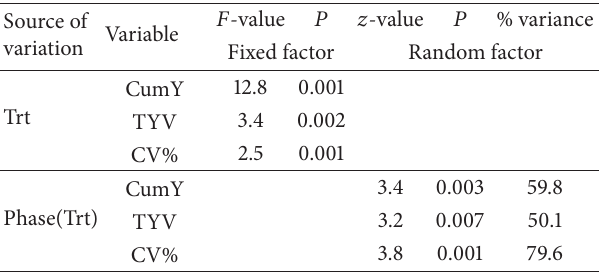
Table 7: Results of the analyses of variance and variance compo- nents analyses for CumY, TYV, and CV in LTE with treatments (Trt) and phase within treatments, Phase(Trt), as fixed and random factors,